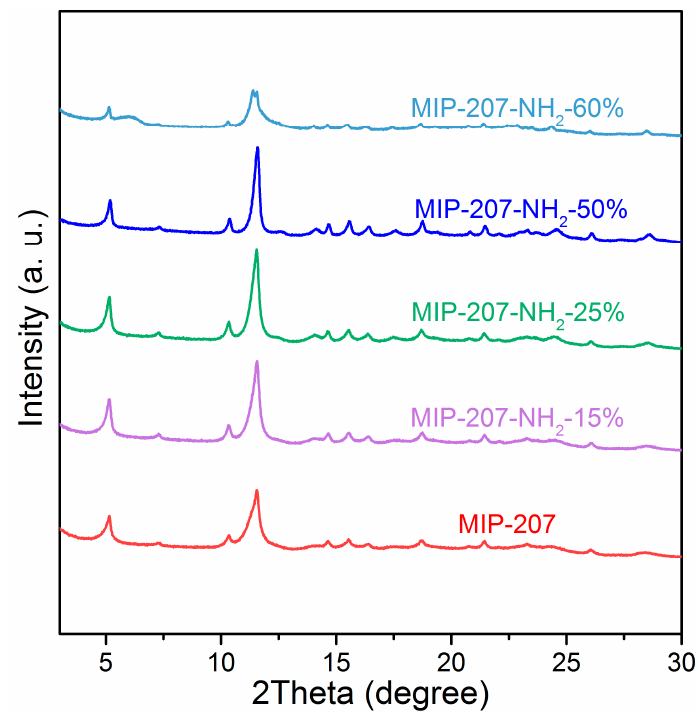
Figure 2. PXRD pattern of